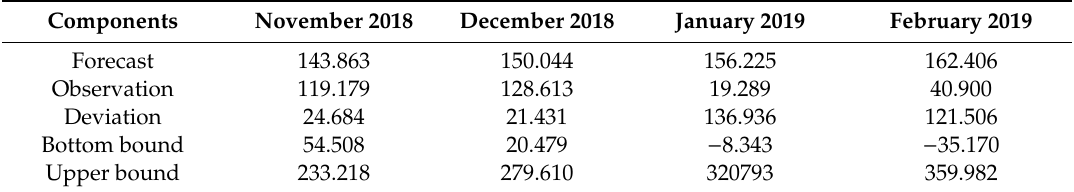
Table A2. Models-2 forecast profit for Bank B in IDR trillion.